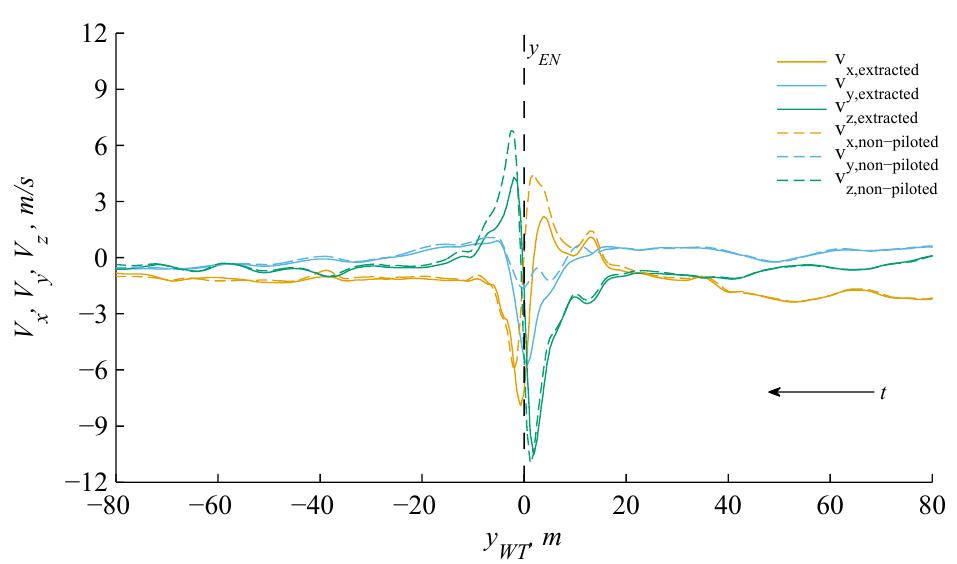
Figure 17. Comparison of the airwake velocities ( V x , V y , V z ) between the non-piloted simulation and an extracted ideally straight line for C1 at position